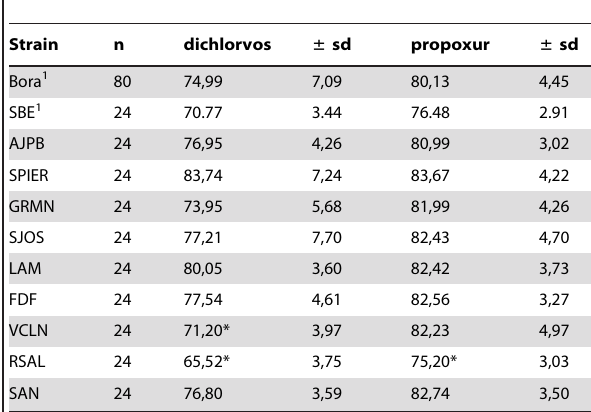
Table 4. Mean percentage of the AChE inhibition by dichlorvos and propoxur in the laboratory strains and the populations of